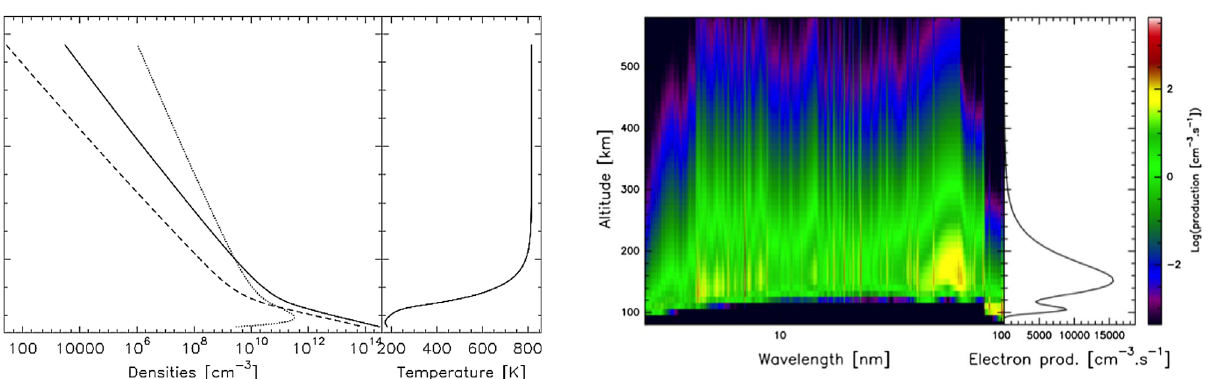
Fig. 1. Left panel: Neutral densities (MSIS, Picone et al., 2002) over Algiers ( F 10.7 = 80, Ap = 3). Full line: N 2 , dotted line: O, dashed line O 2 . Right panel: Neutral temperature.